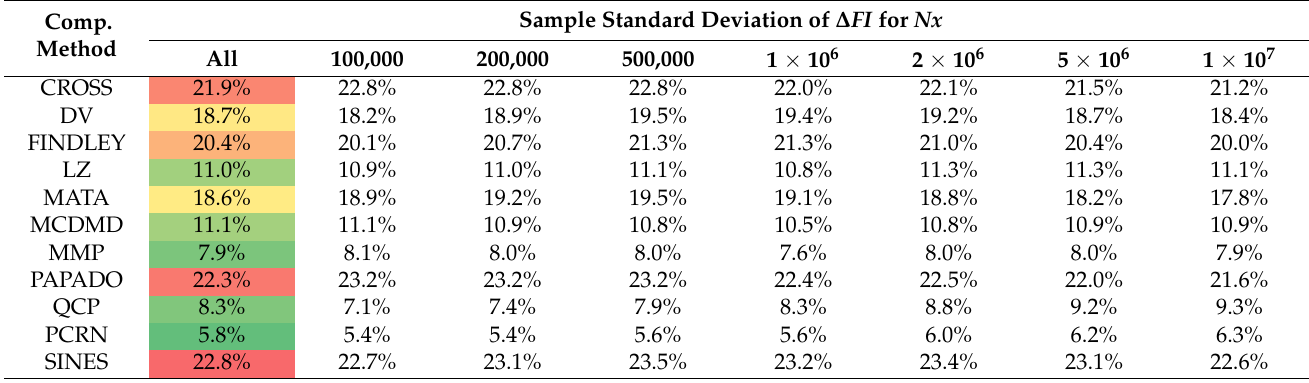
Table 9. Results of the ∆ FI statistics for 11 methods at different Nx —sample standard deviations.